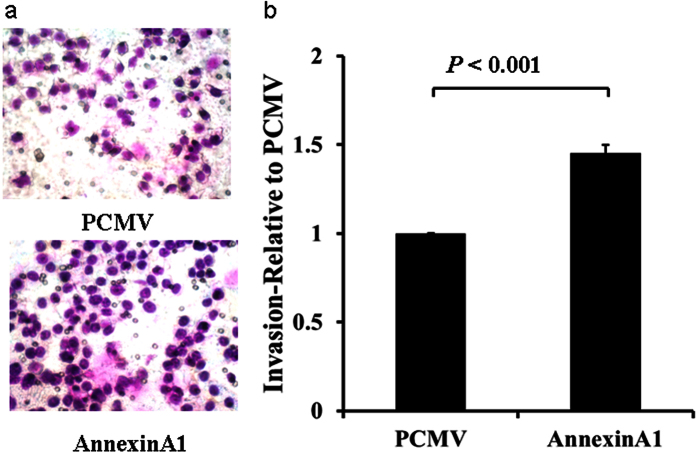
Overexpression of Annexin A1 in AGS cell promotes invasion.Invasion assay was conducted in AGS cells transfected with an expression plasmid carrying Annexin A1 cDNA or the empty vector PCMV using 24-well Transwell chambers. (a) Representative images of invaded cells in PCMV and Annexin A1 plasmid transfected cells. (b) Cell invasion was assessed by counting the number of AGS cells that invaded through the transwell insert by light microscopy on 3 independent membranes, then normalized against the NC treated cells to determine the relative ratio.